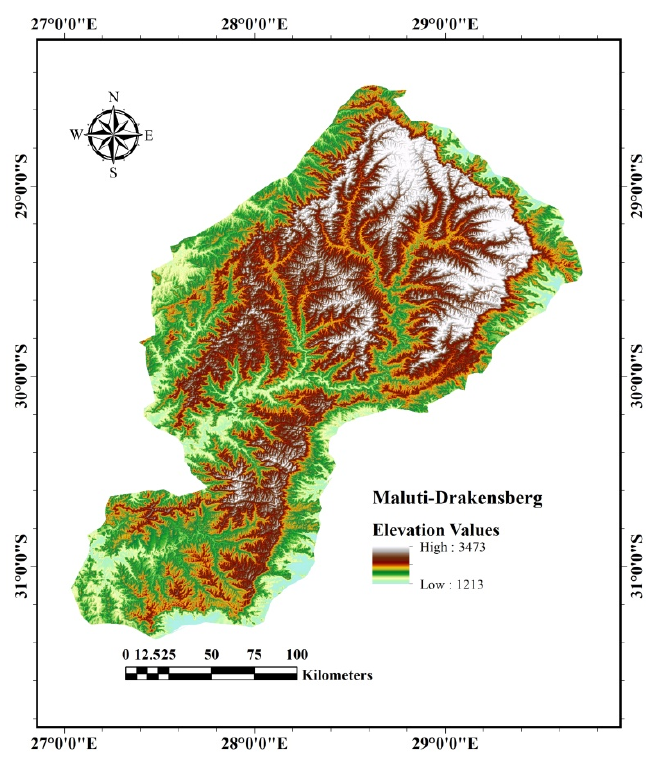
Figure 1. Maloti-Drakensberg Region.